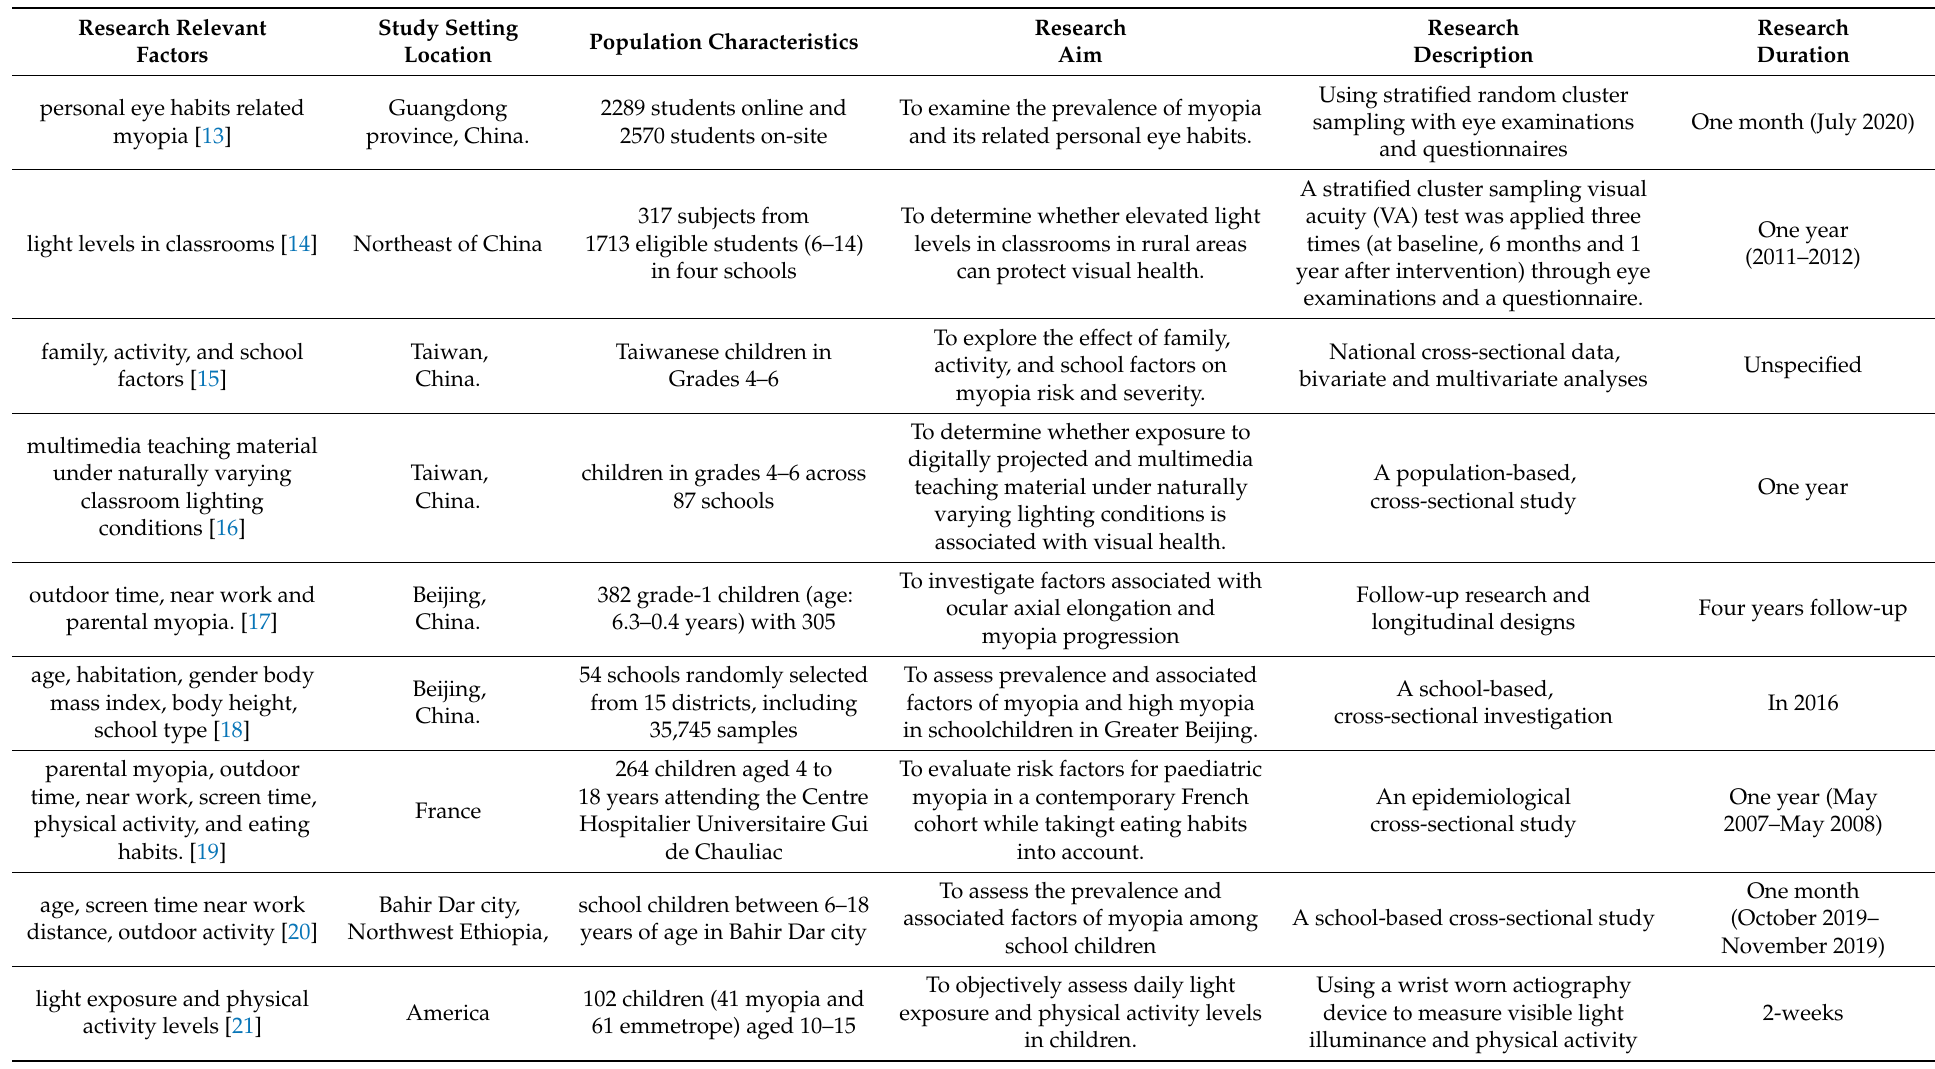
Table 1. Overview of researches in the Review of Visual Health Risk Factors in